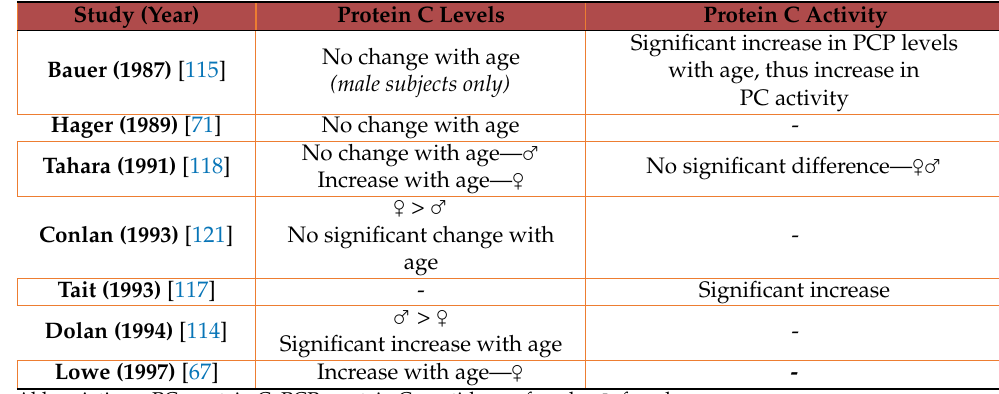
Table 2. Age-related changes in protein